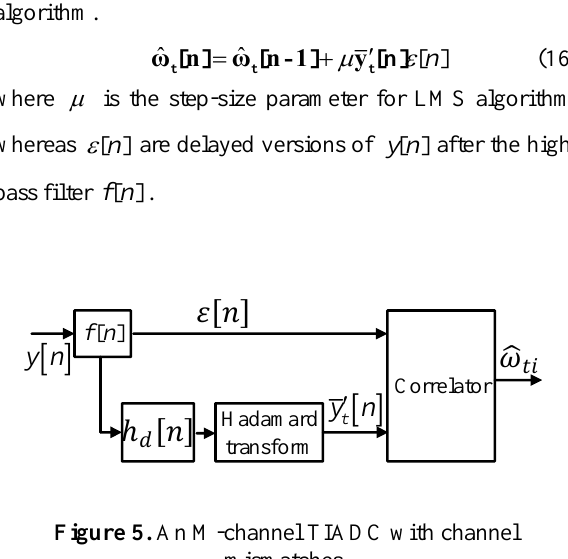
Figure 5. An M-channel TIADC with channel mismatches.